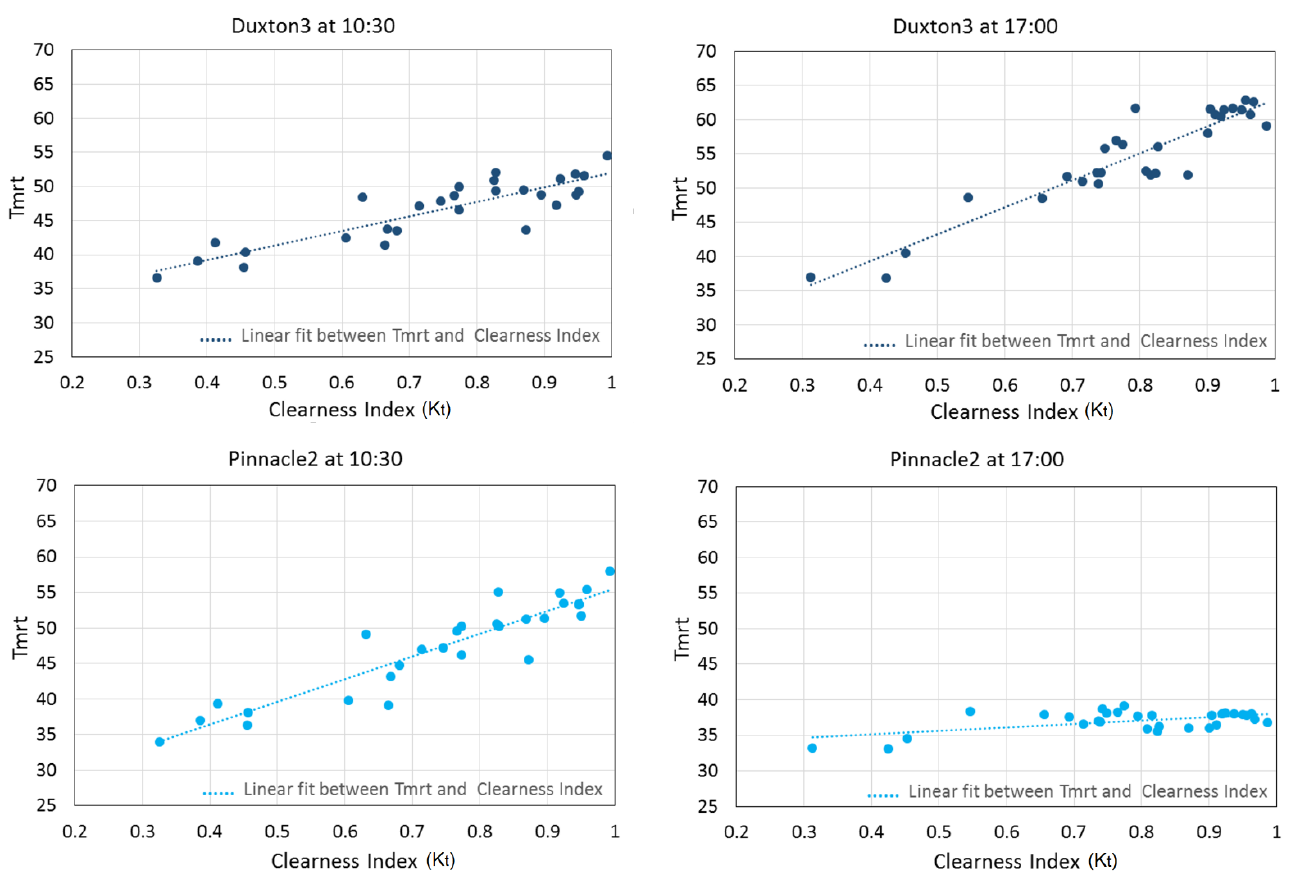
Figure 8. Relation between T mrt and the Clearness Index in the shade and non-shaded sites in the morning and afternoon (Duxton3 and Pinnacle2) during August 2019.